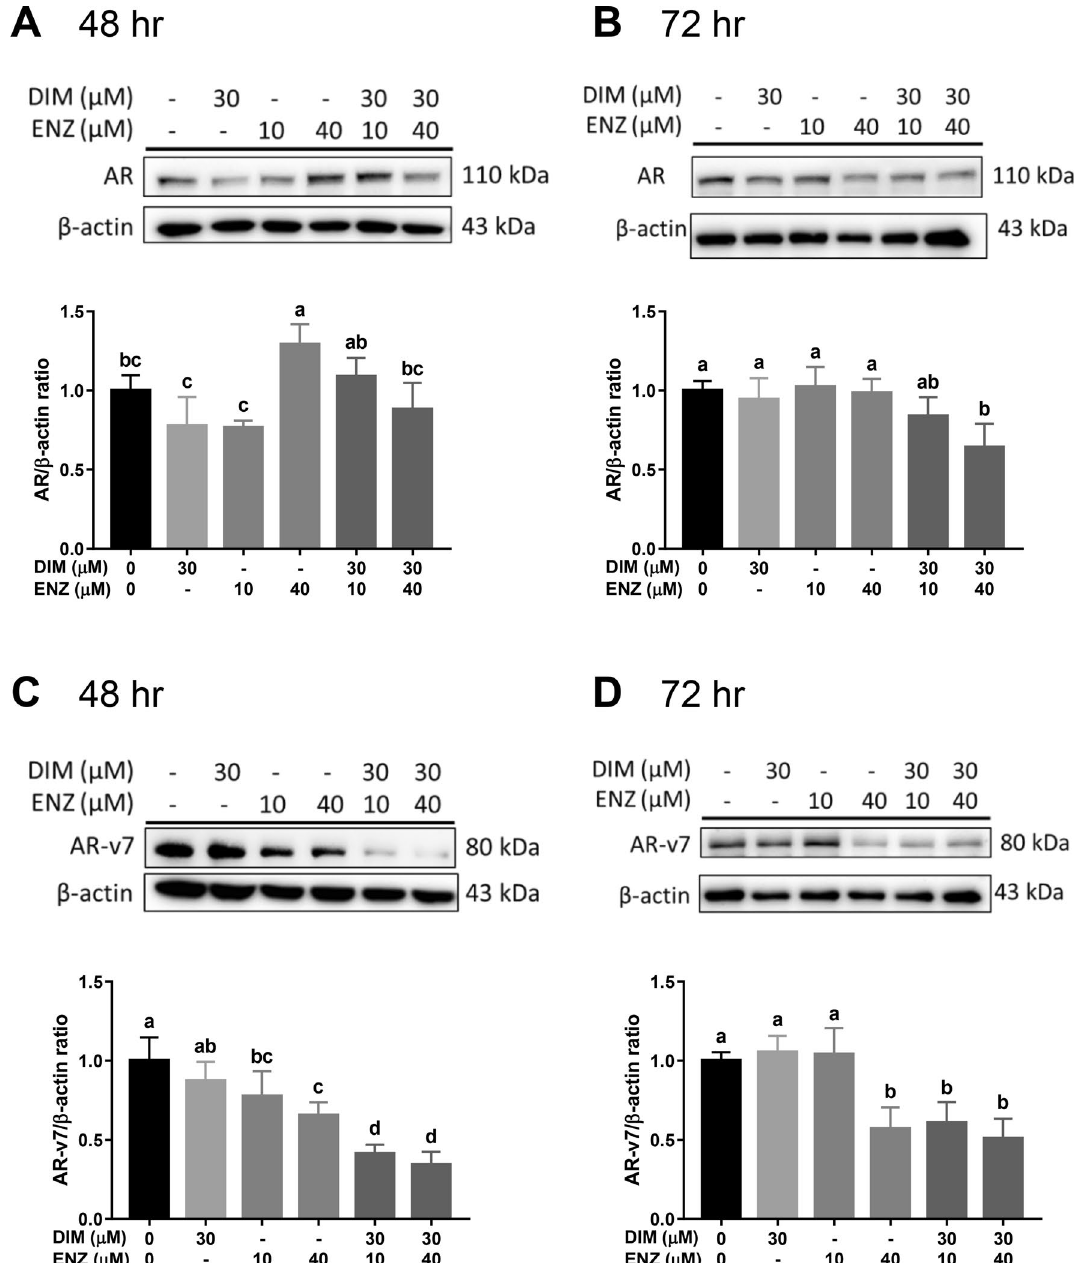
Figure 7. DIM and ENZ downregulate AR and AR-v7 protein expressions. AR expression at 48 ( A ) and 72 h ( B ); AR-v7 expression at 48 ( C ) and 72 h ( D ). DIM 3,3 ′ -diindolylmethane; ENZ enzalutamide. a,b,c,d Bars without the same letters at the top indicate statistically-significant differences between treatments when compared with each other (one-way ANOVA, Duncan’s new multiple range test, p <